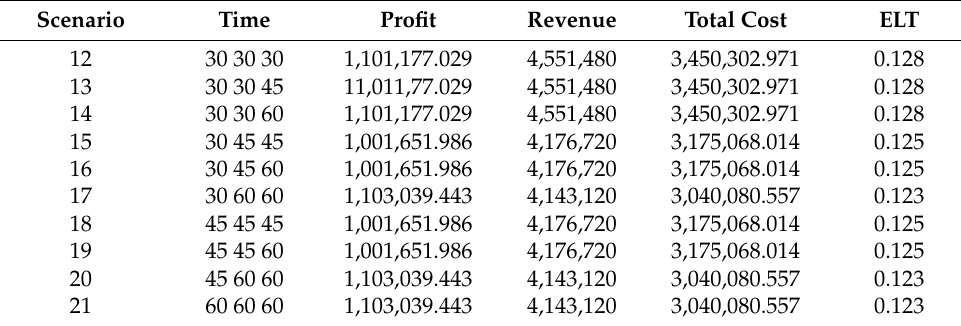
Table 4. The SC performance when the epidemic propagates to market (demand increases by 10